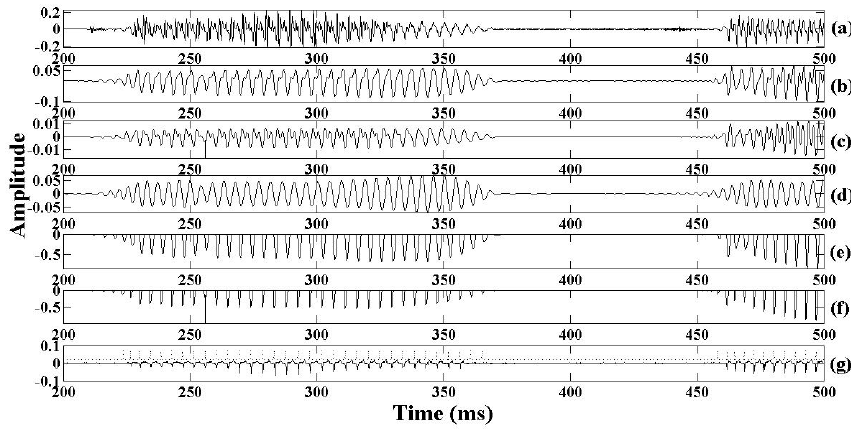
Figure 4. (a) Female speech signal segment. (b) LPF speech signal. (c) Derivative of LPF speech signal. (d) Fundamental harmonic component. (e) Extracted peak